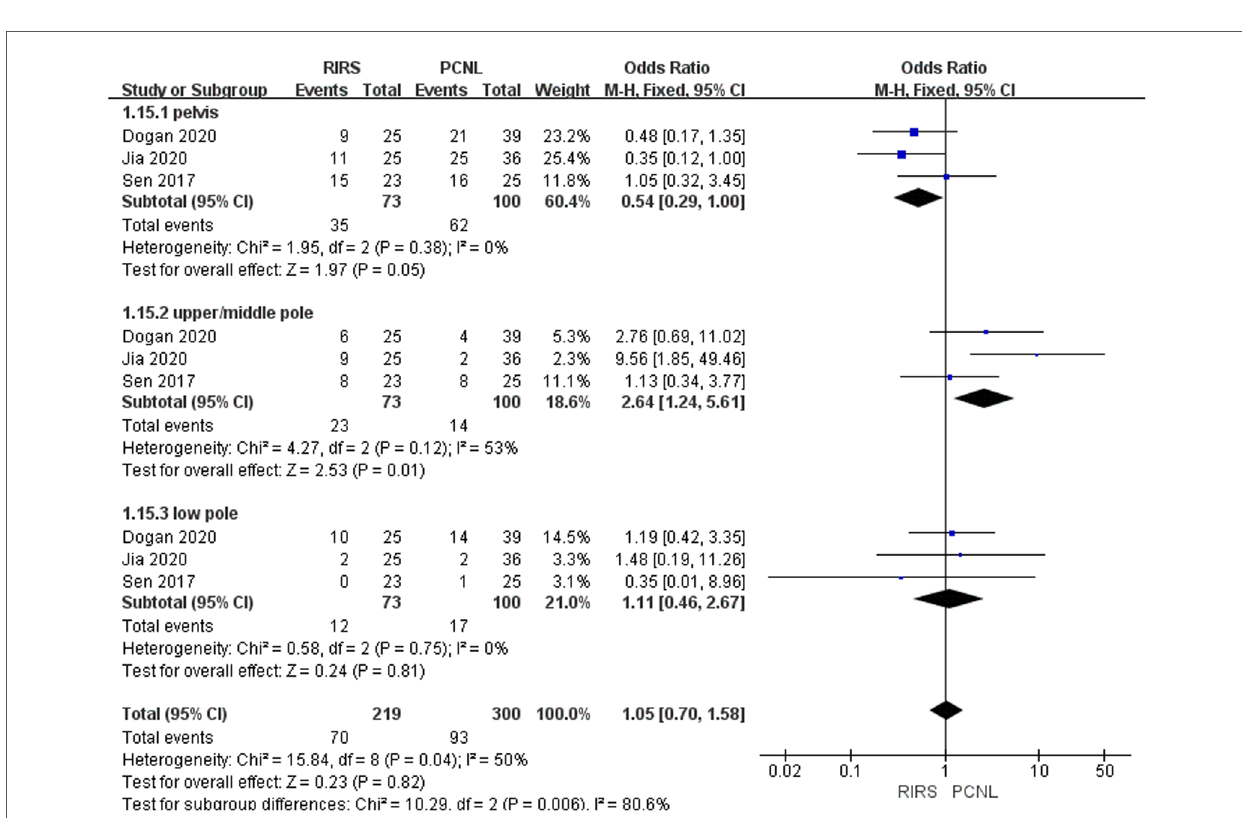
FIGURE 7 Forest plot of stone location between the RIRS group and the micro-PCNL